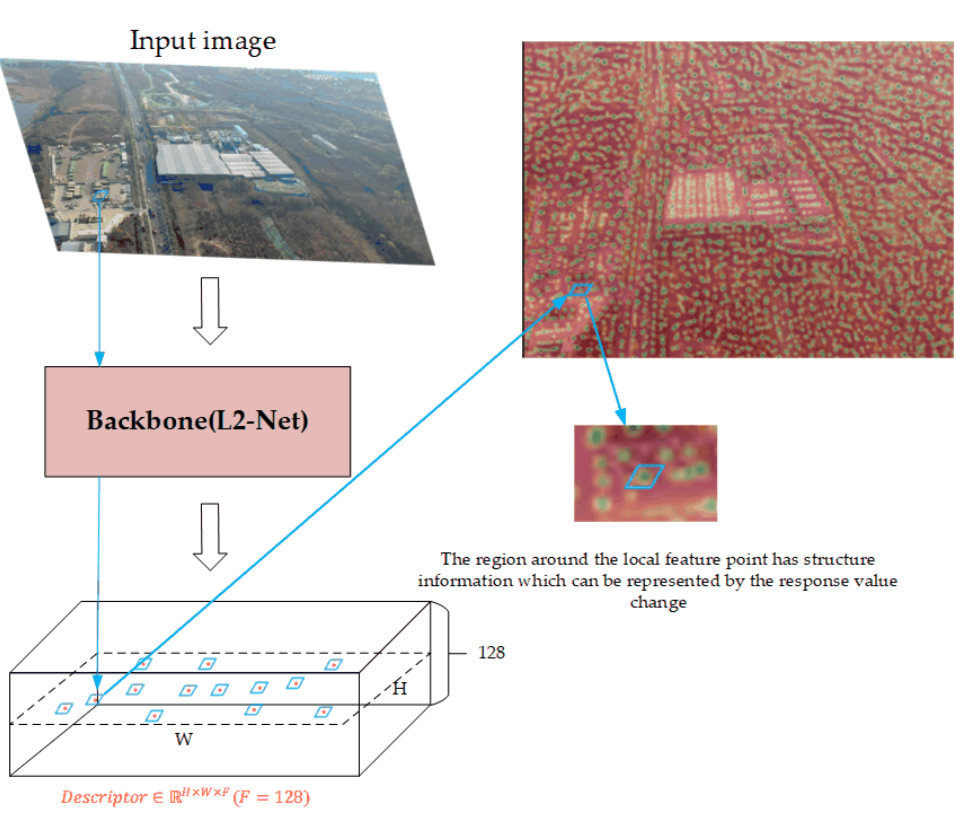
Figure 5. The description processing of the local feature on one of the input images.